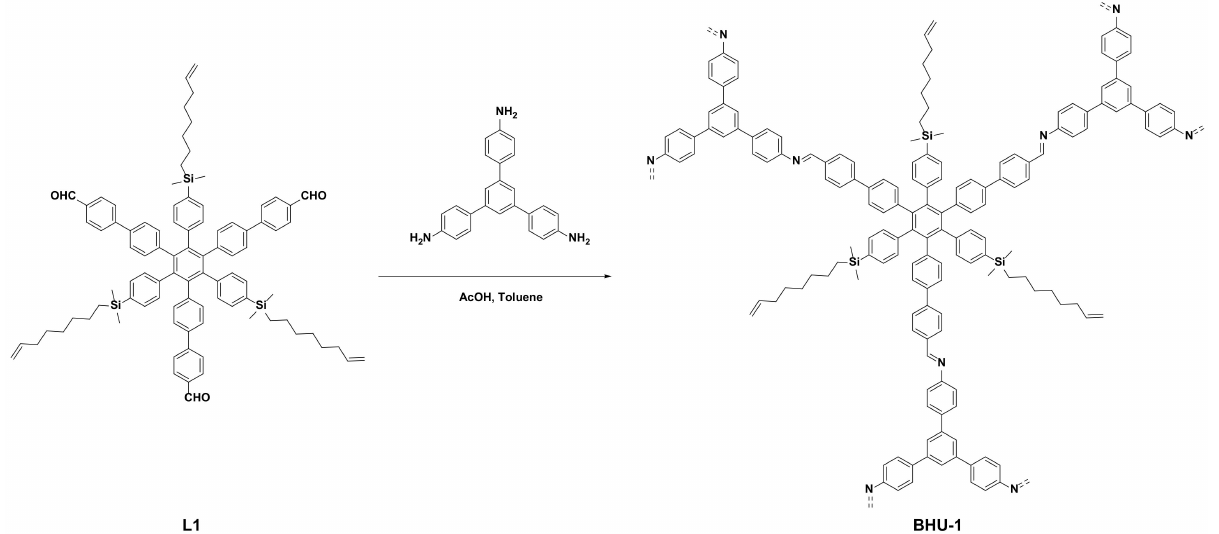
Scheme 1. Synthesis of C 3 symmetrical aldehyde L1 with pedant alkene